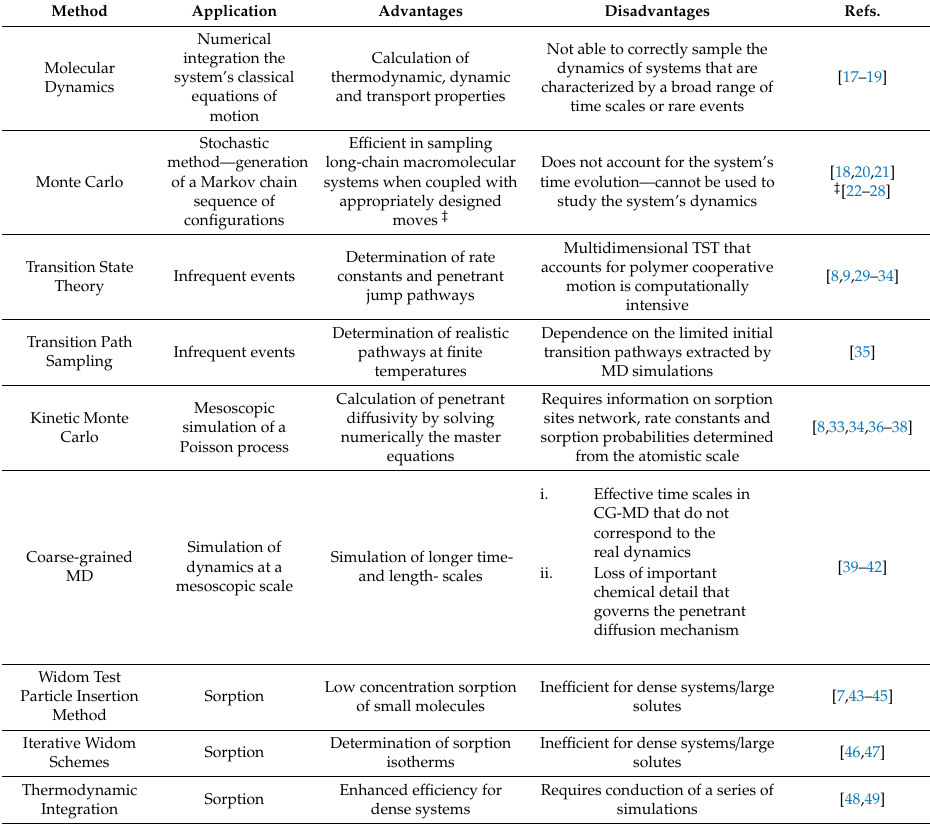
Table 1. Compact summary of representative computational methods and their applicability for the prediction of solubility and di ff usivity in glassy